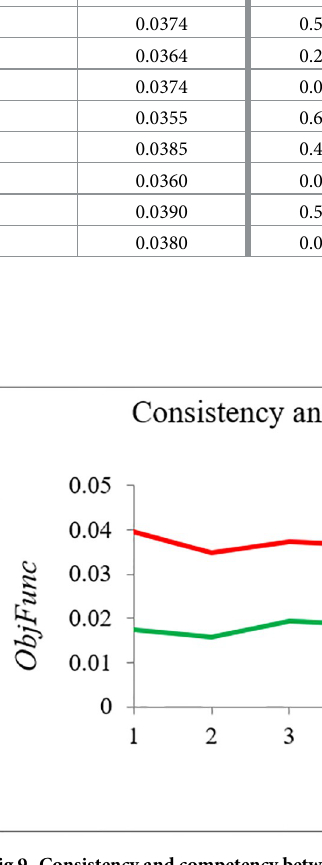
Fig 9. Consistency and competency between trinlm and